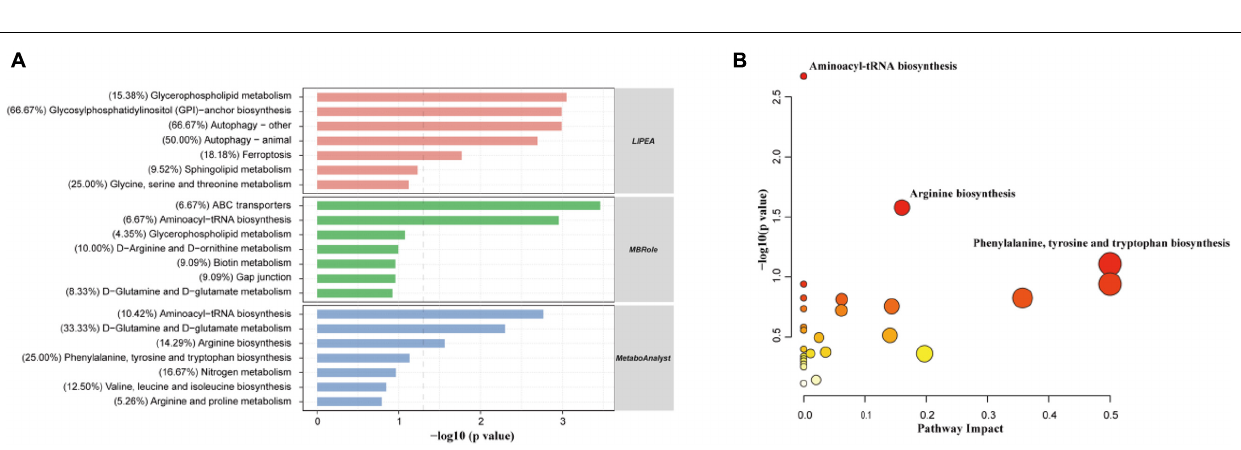
Frontiers in Microbiology |